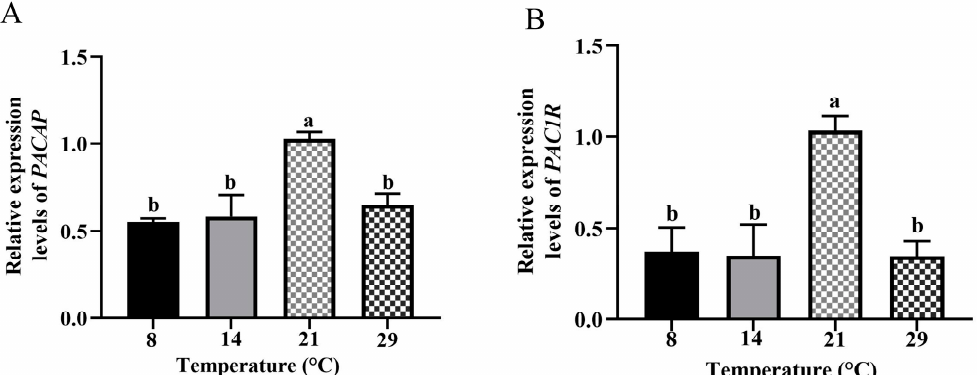
Figure 4. Comparations of the expression levels of PACAP ( A ) and PAC1R ( B ) in the hypothalamus of Phodopus sungorus at 8 °C, 14 °C, 21 °C, and 29 °C. Data are expressed as means ± SEM. n = 4. Different letters above the columns indicate significant differences ( p < 0.05 or p < 0.01).